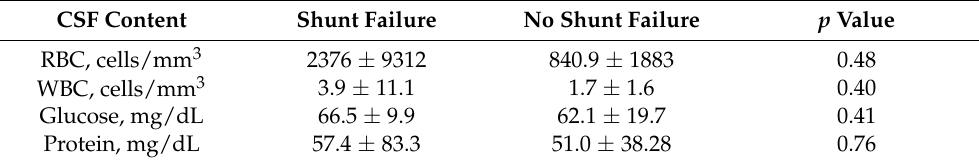
Table 3. CSF content prior to shunt placement in patients with